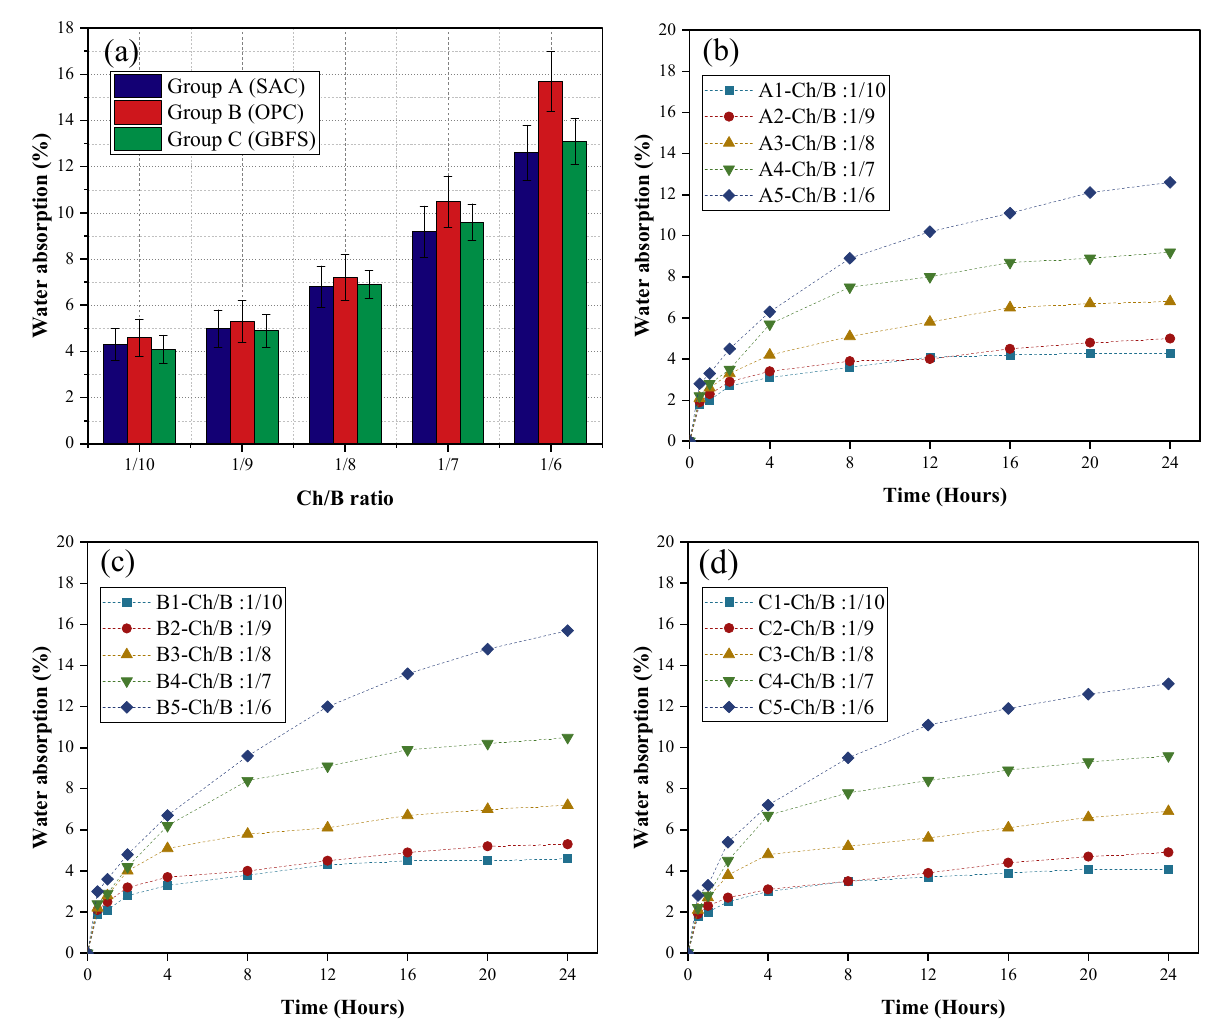
Figure 9. The results of the water absorption rate: ( a ) water absorption rate of the different groups over 24 h; ( b ) water absorption rate of the SAC specimen; ( c ) water absorption rate of the OPC specimen; ( d ) water absorption rate of the GBFS specimen.